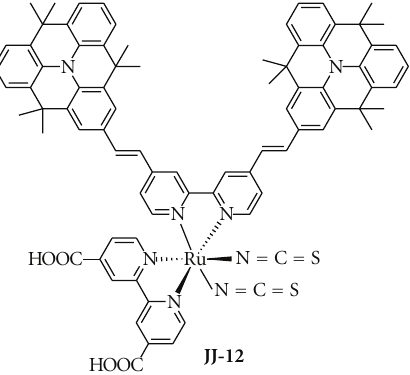
Figure 1: Molecular structure of JJ-12